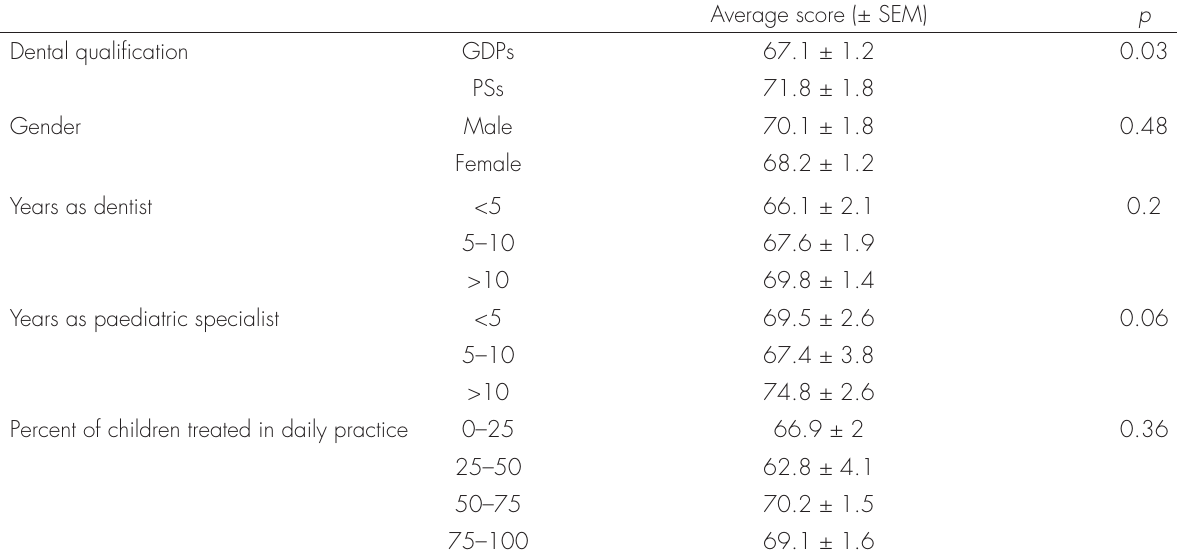
Table II. Average scores according to participants’ biographic details.